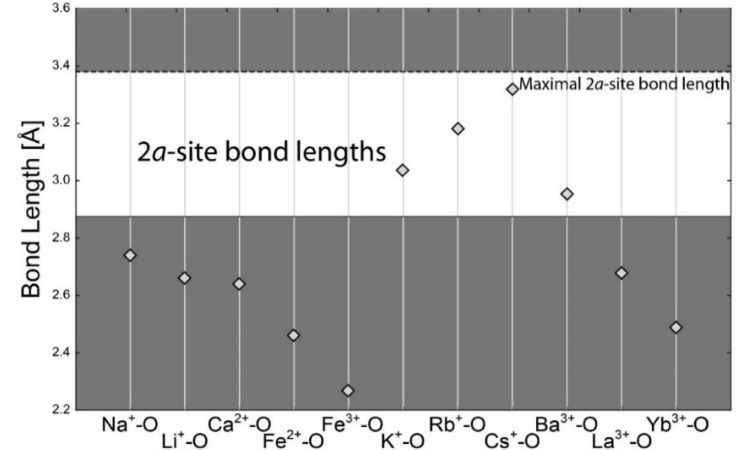
Figure 5. Calculated bond lengths for each bond in the 12-fold coordination of cation (2 a site). The horizontal dashed line is for maximal empirical bond length. The horizontal full line is the 15% limit for free substitution. The free-substitution area is white. The substitution is significantly limited for cations in the grey